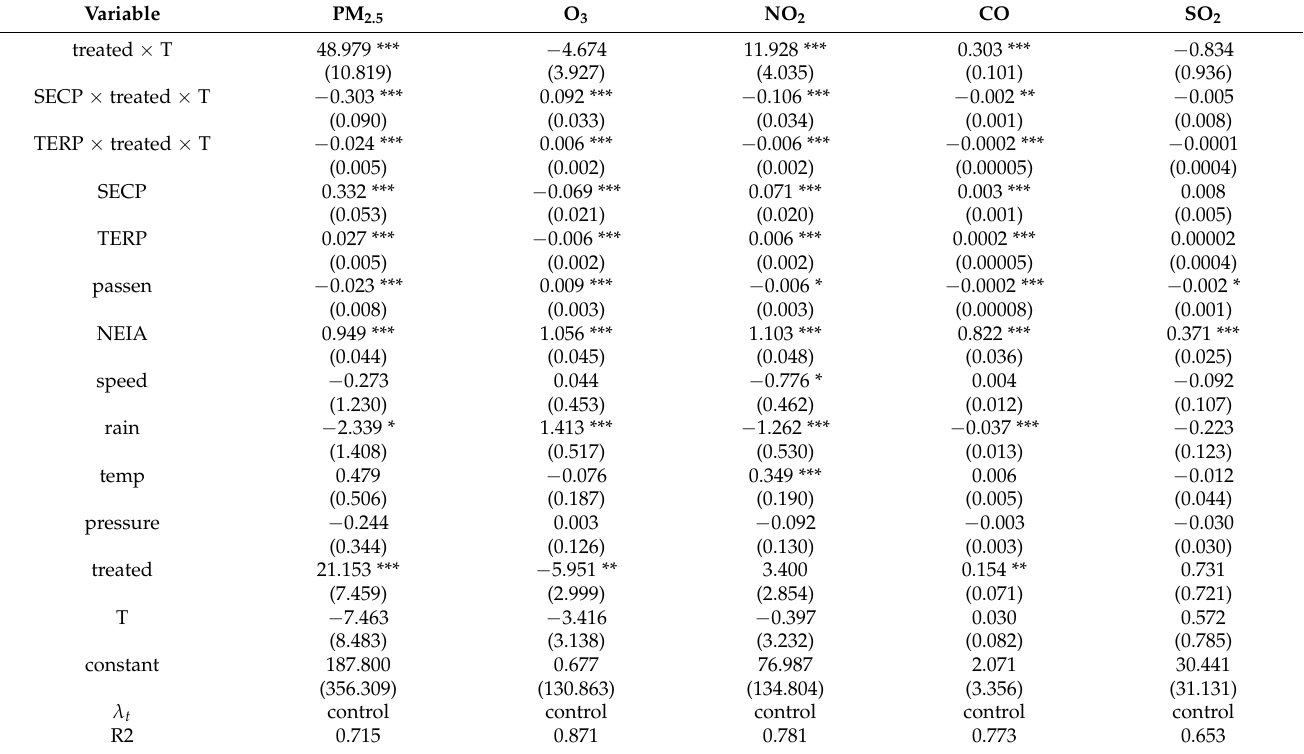
Table 6. DID regression results of industrial adjustment on specific